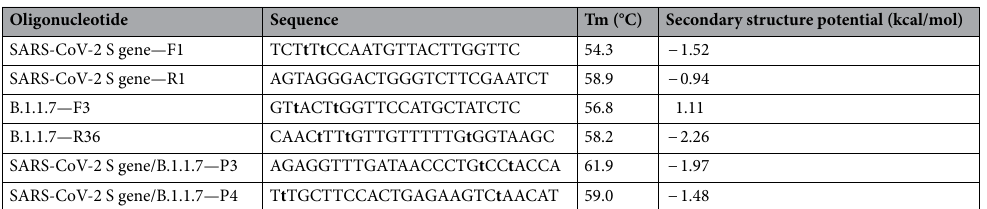
Table 2. Oligonucleotide primers and probes for common SARS-CoV-2 S gene and B.1.1.7 primer/probe sets. Nucleotides in lowercase and bold denote LNA-modified bases. F forward primer, P probe, R , reverse primer.